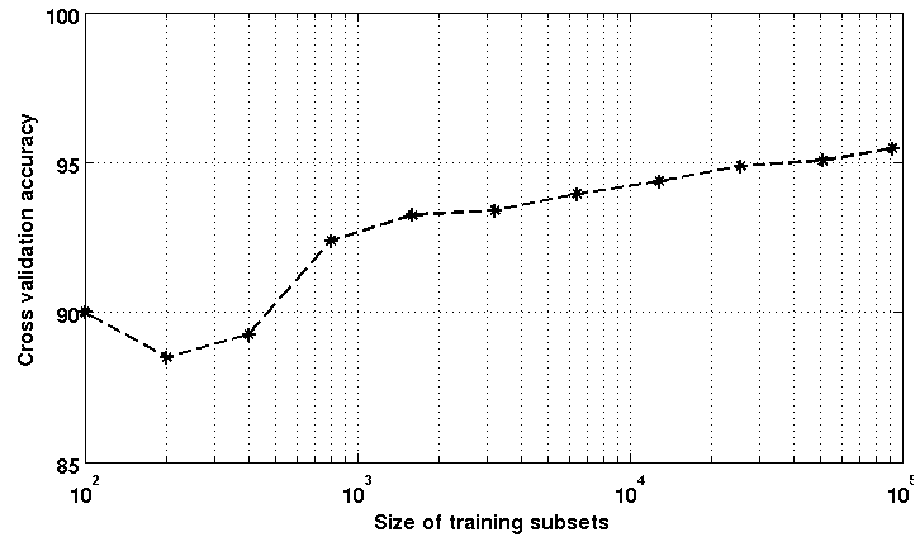
Figure 2. The cross-validation accuracy (in percentage) versus the size of the training subsets.